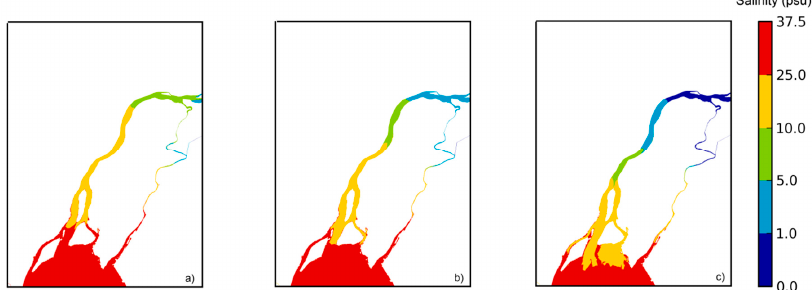
Figure 3. Illustration of the sensitivity of the mean salinity model results to the river flow: mean river flow at the Tagus river boundary of ( a ) 22 m 3 /s, ( b ) 44 m 3 /s, and ( c ) 88 m 3 /s.